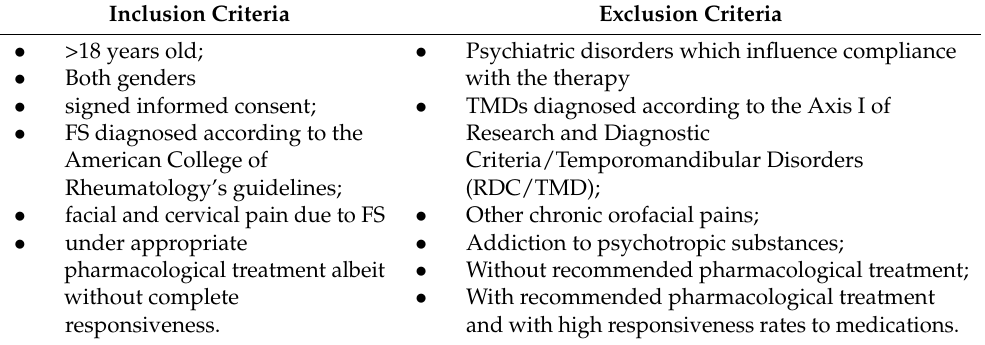
Table 1. Inclusion and exclusion criteria.